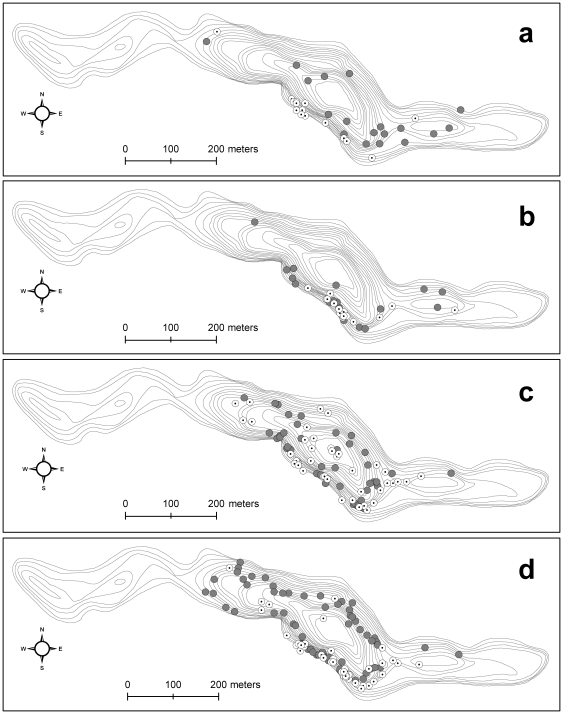
Localizations of individuals from tactics I–IV (a–d) in 2005.Open symbols: day (9 am–3 pm); filled symbols: night (9 pm–3 am). Radio-tracking data are pooled for all individuals that belonged to a given tactic (tactic I: two individuals; tactic II: two individuals; tactic III: five individuals; tactic IV: seven individuals). Isobaths are shown (1 m intervals; maximum depth  = 17 m).